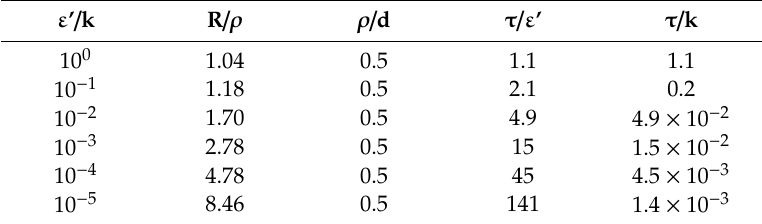
Table 1. The table depicts an optimal design for various degrees of e ff ective adhesion ε ’ with respect to the cell envelope sti ff ness k, based on a numerical evaluation of the model (see Supplementary Materials Section